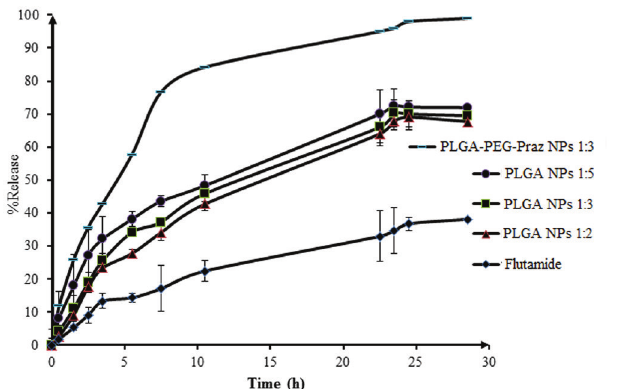
flutamide‑loaded nanoparticles with drug to PLGA ratio of